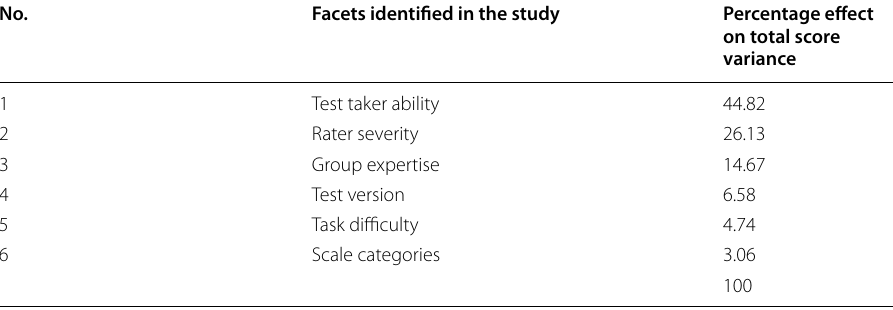
Table 5 Effect of each facet on total score variance (pre‑training)